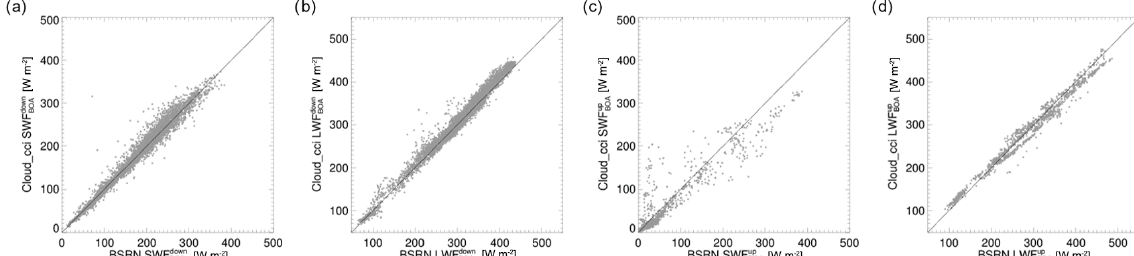
Figure 5. Comparison of Cloud_cci bottom of atmosphere (BOA) shortwave (SW; panel a ) and longwave (LW; panel b ) downwelling fluxes with ground-based reference measurements taken at globally distributed Baseline Surface Radiation Network (BSRN) sites for which equivalent reference data were available. Panels (c) and (d) are as in (a) and (b) but for upwelling fluxes. Shown are all monthly data pairs within the period